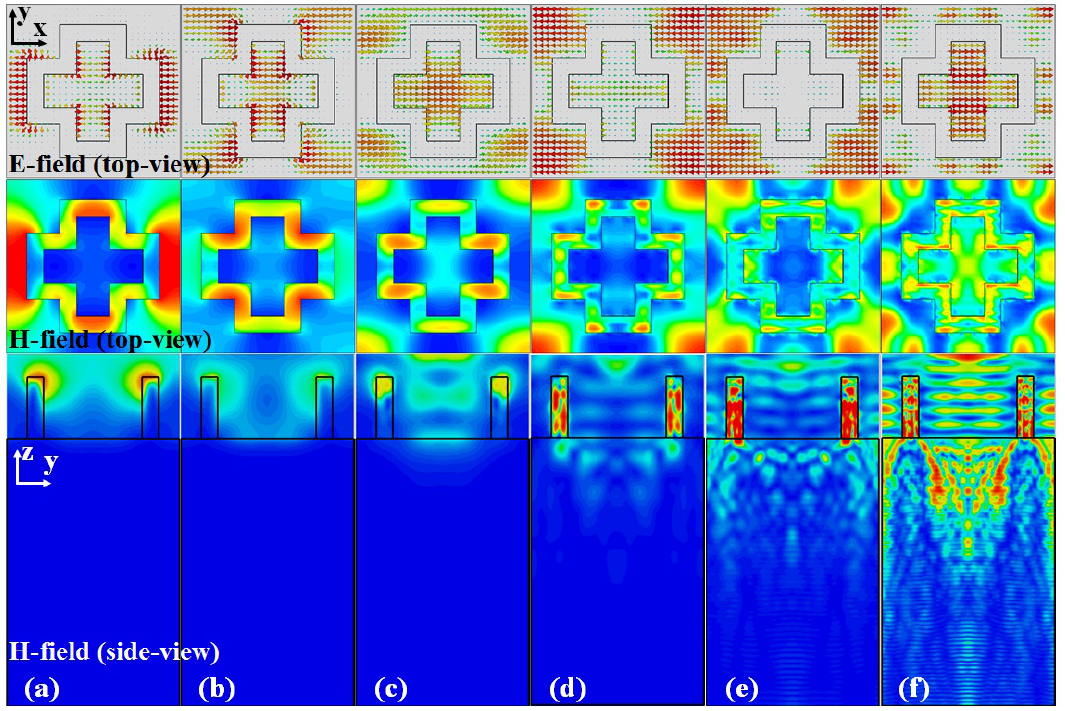
Figure 3. Simulated electric and magnetic field patterns for the absorber at ( a ) 0.75 THz, ( b ) 1.38 THz, ( c ) 3.23 THz, ( d ) 5.10 THz, ( e ) 7.13 THz and ( f ) 9.12 THz, respectively. The first and second row show the electric and magnetic fields (top-view), respectively, while the third row illustrates the magnetic fields